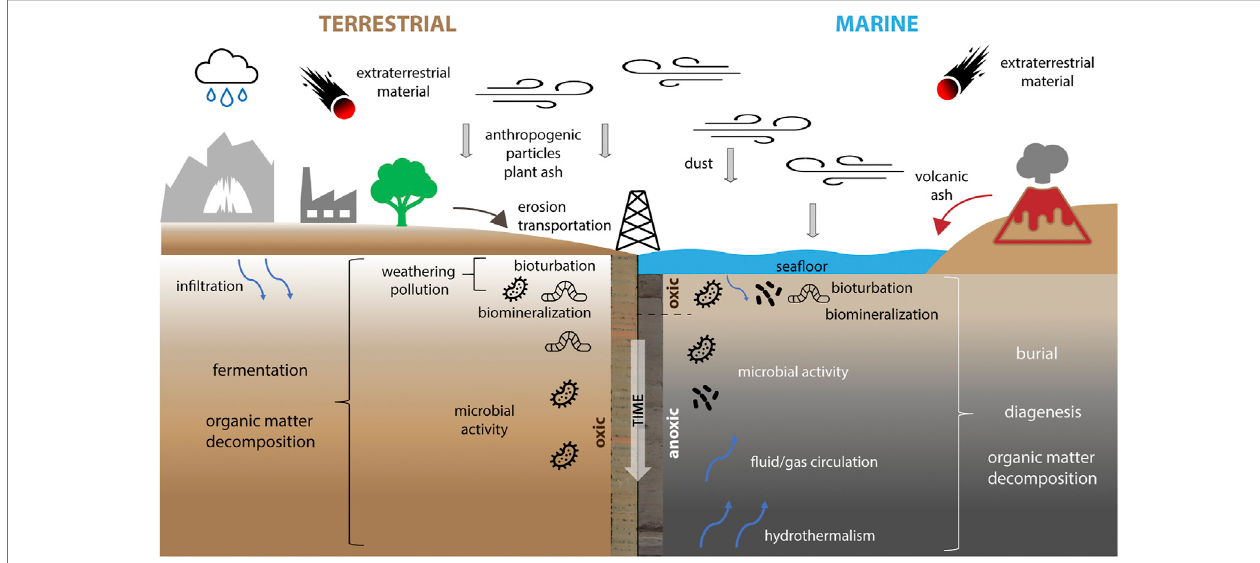
FIGURE1| Graphicalsynthesis ofcontributionstothisSpecialIssue,highlightingthemainsourcesofmagneticmaterial interrestrial andmarine environments, the physiochemical conditions at the burial site, and the depositional and post-depositional processes that affect the magnetic signal in the geological environment.